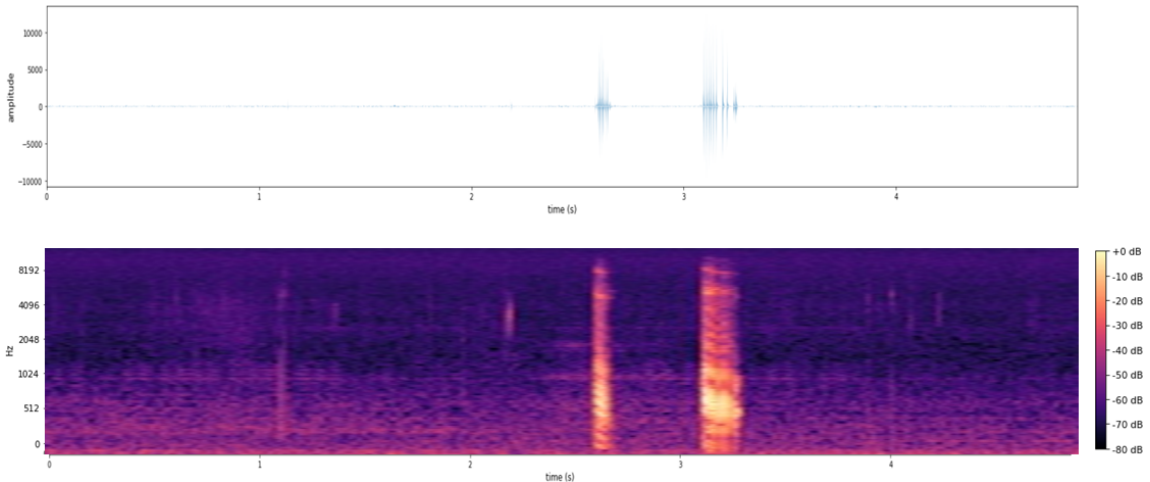
Figure 10. Example of anuran call: waveform (up) and mel-spectrogram (down). As can be seen in the figure, the anuran call is located in the interval (2.5, 3.5 s) of the sample. The mel-spectrogram allows identification, in the image, of both the location of the call and the range of frequencies and amplitudes of the same.